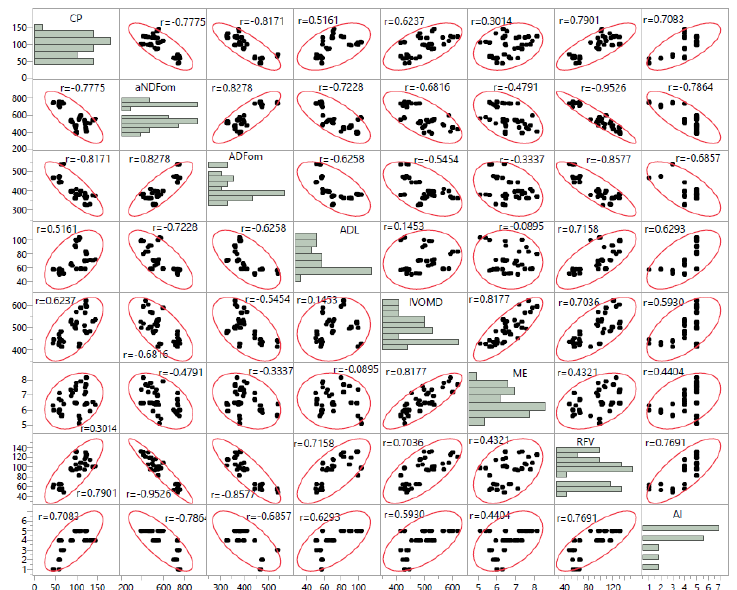
Figure 6. Correlation coefficients between quality attributes (CP; g/kg DM), acid detergent fiber (ADFom; g/kg DM), neutral detergent fiber (aNDFom; g/kg DM), acid detergent lignin (ADL; g/kg DM), in vitro organic matter digestibility (IVOMD; g/kg DM), metabolizable energy (ME; MJ/kg) and relative feed value (RFV), acceptability index (AI) of twelve native perennial species from arid rangelands of southern Tunisia.